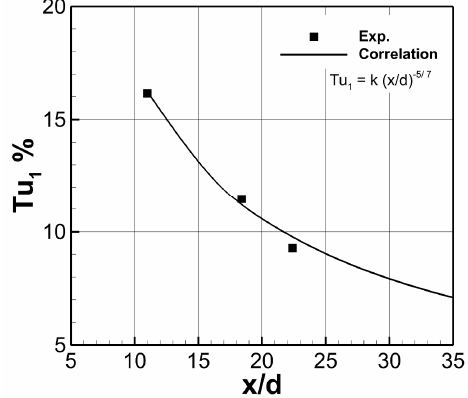
Figure 7. Inlet turbulence intensity ( Tu 1 ) decay.